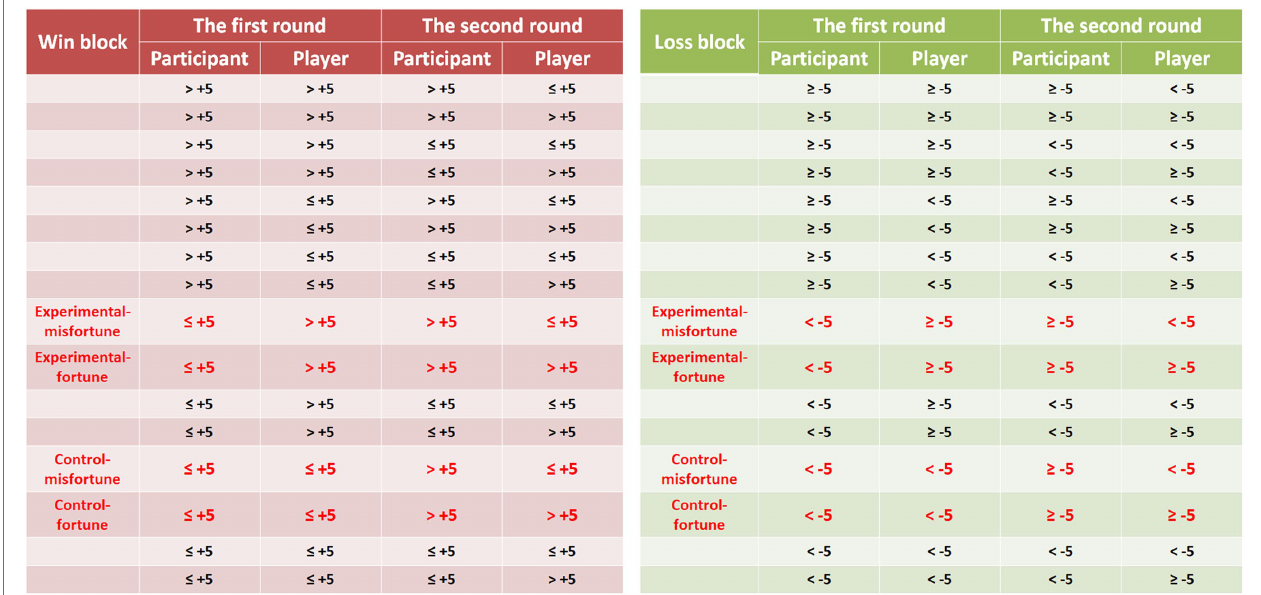
TABLE 2 | Mean ratings of envy and schadenfreude and the SDs for all experimental conditions in Experiment 2. Loss Win M SD M SD Envy ratings